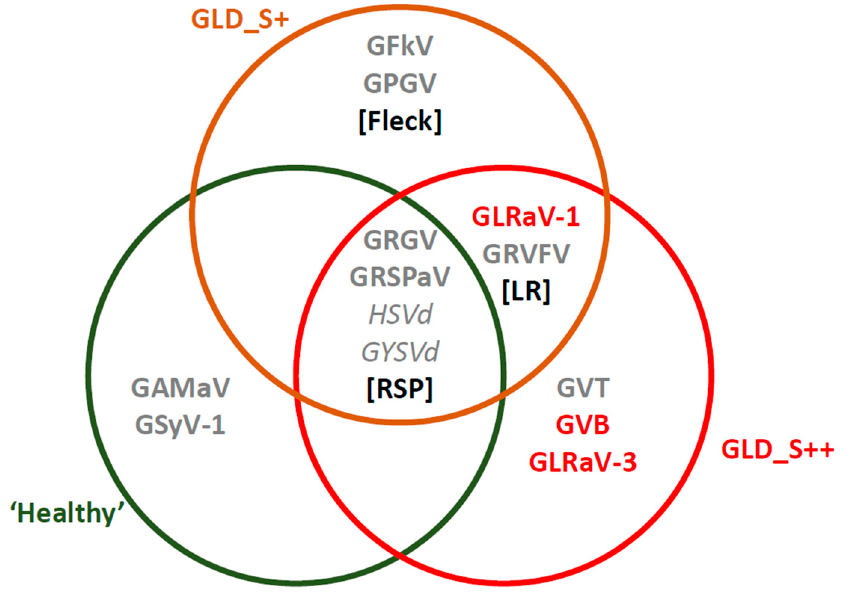
Figure 5. Representation of the viruses detected by High throughput sequencing and pathogen detected by biological indexing in different group (‘healthy’ (symptomless) in green, GLD_S+ in brown and GLRD_S++ in red). Colour of the virus front based on the expected pathogenicity: background (grey) or pathogen (red). Biological indexing positive detection are marked in black in []. LR is for leafroll disease observed on Vitis vinifera ‘Gamay’. Fleck is for fleck detection on Vitis rupestris ‘Saint Georges’. RSP is for Rupestris stem pitting detection on Vitis rupestris ‘Saint Georges’. Corky bark (CB) on LN33 (1613 Couderc x Thompson Seedless) and Kober stem-grooving (KSG) on Kober 5BB were also tested but all the treatments returned negative. Virus acronyms: GRSPaV—grapevine rupestris stem pitting-associated virus; GRGV—grapevine red globe virus; GAMaV—grapevine asteroid mosaic-associated virus; GSyV-1—grapevine Syrah virus 1; GFkV—grapevine fleck virus; GPGV—grapevine Pinot gris virus; GLRaV-1—grapevine leafroll-associated virus 1; GLRaV-3—grapevine leafroll-associated virus 3; GRVFV—grapevine rupestris vein feathering virus; GVT—grapevine virus T; GVB—grapevine virus B.